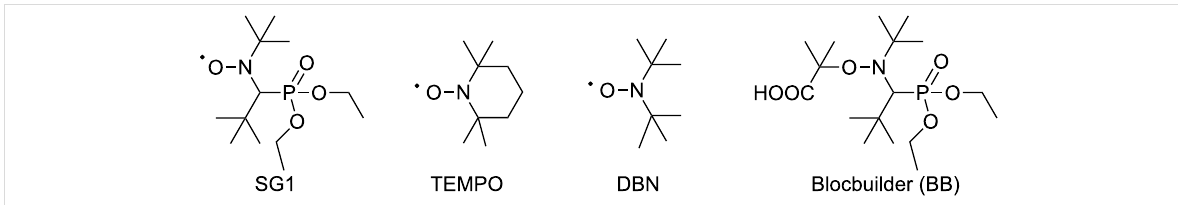
Figure 1: Structure of the SG1, TEMPO and DBN nitroxides and the BlocBuilder MA